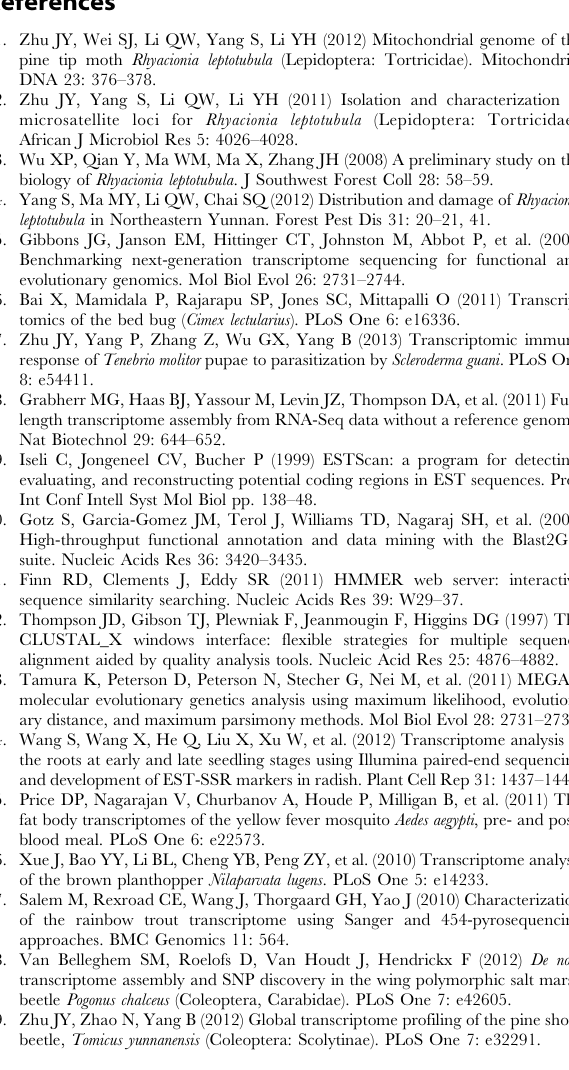
Table S3 Pathway assignment based on KEGG. Table S4 Pfam domain sereched in the unigenes. Table S5 Detailed information of the designed primers. Table S6 Randomly selected SSR markers used to validate the